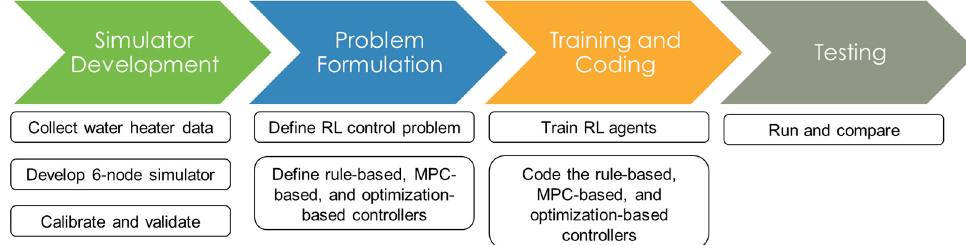
Figure 1. The framework of the methodology.